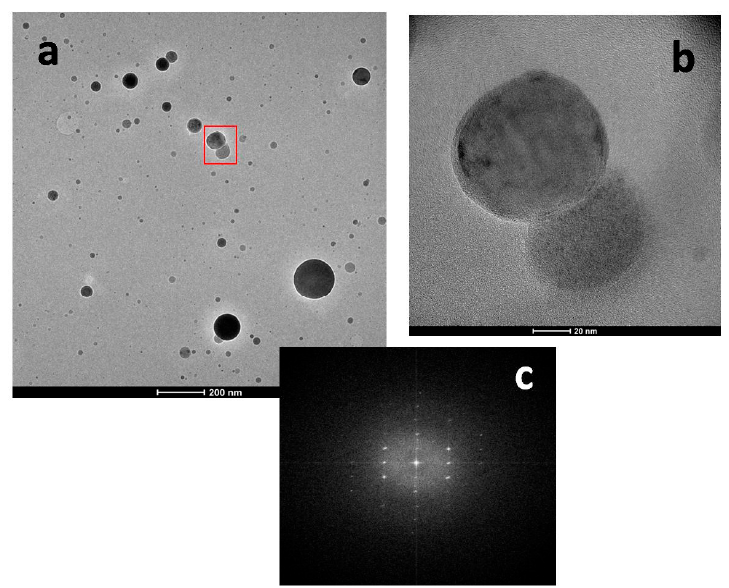
Figure 8. ( a ) HR-TEM micrograph of the first steps of the growth of a film deposited at room temperature; ( b ) HR-TEM micrograph of two NPs from Figure 7a; and ( c ) FFT image showing distances corresponding to the lattice spacings of (125), (104), (110) and (101) planes of boron and of (101), (100), and (001) planes of CrB 2 .